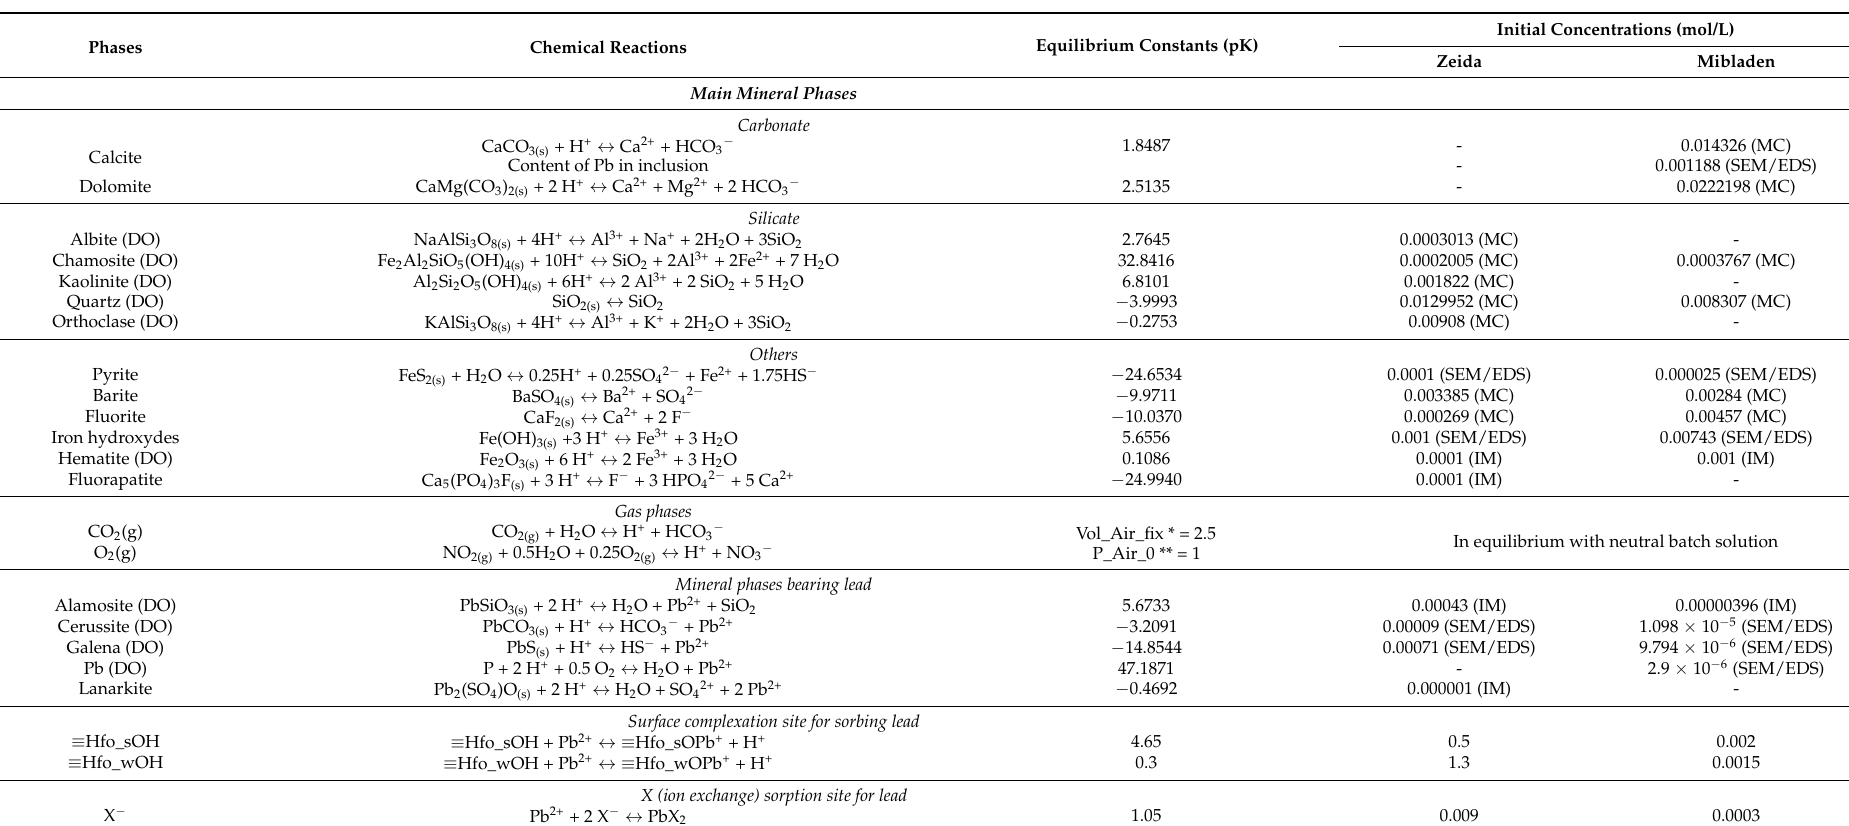
Table 2. Mineral assemblages obtained by inverse modeling (the “Phases” column), dissolution/precipitation reactions with thermodynamic constants (“Chemical Reactions” and “Equilibrium Constants”), and initial concentrations in the assemblage; surface complexation and cationic exchange sites are described in the three bottom rows. For thermodynamic constants, refer to the llnl database